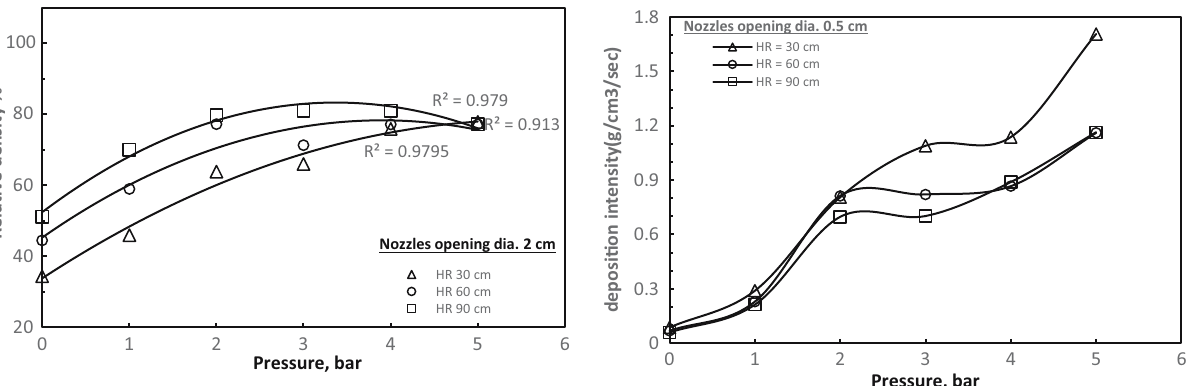
Figure 7: Variation of RD, TAP, and HF for nozzle size of 2.0 cm.